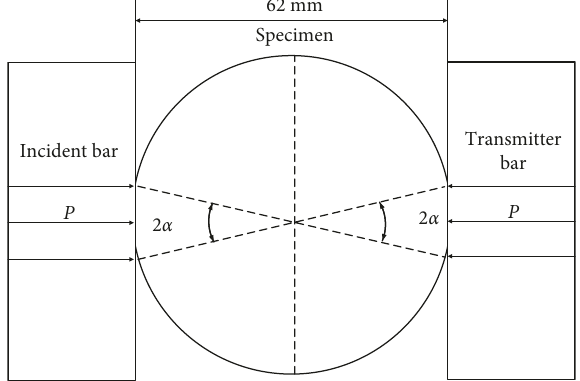
Figure 6: Flattened BD specimen under radial impact loading.